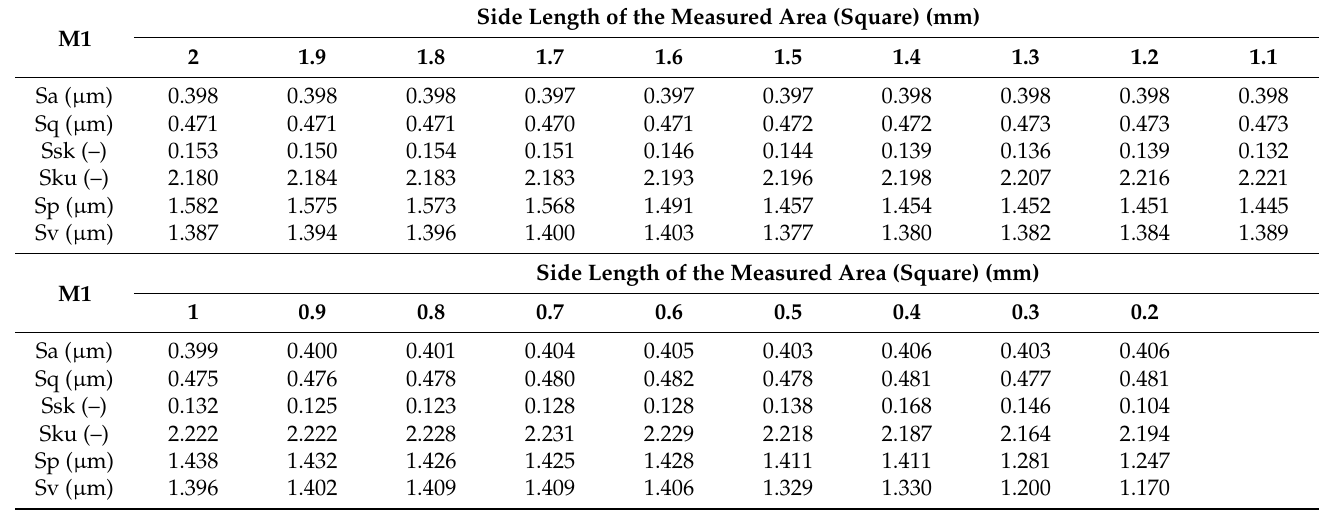
Table A2. Surface roughness values for the procedure version M1.